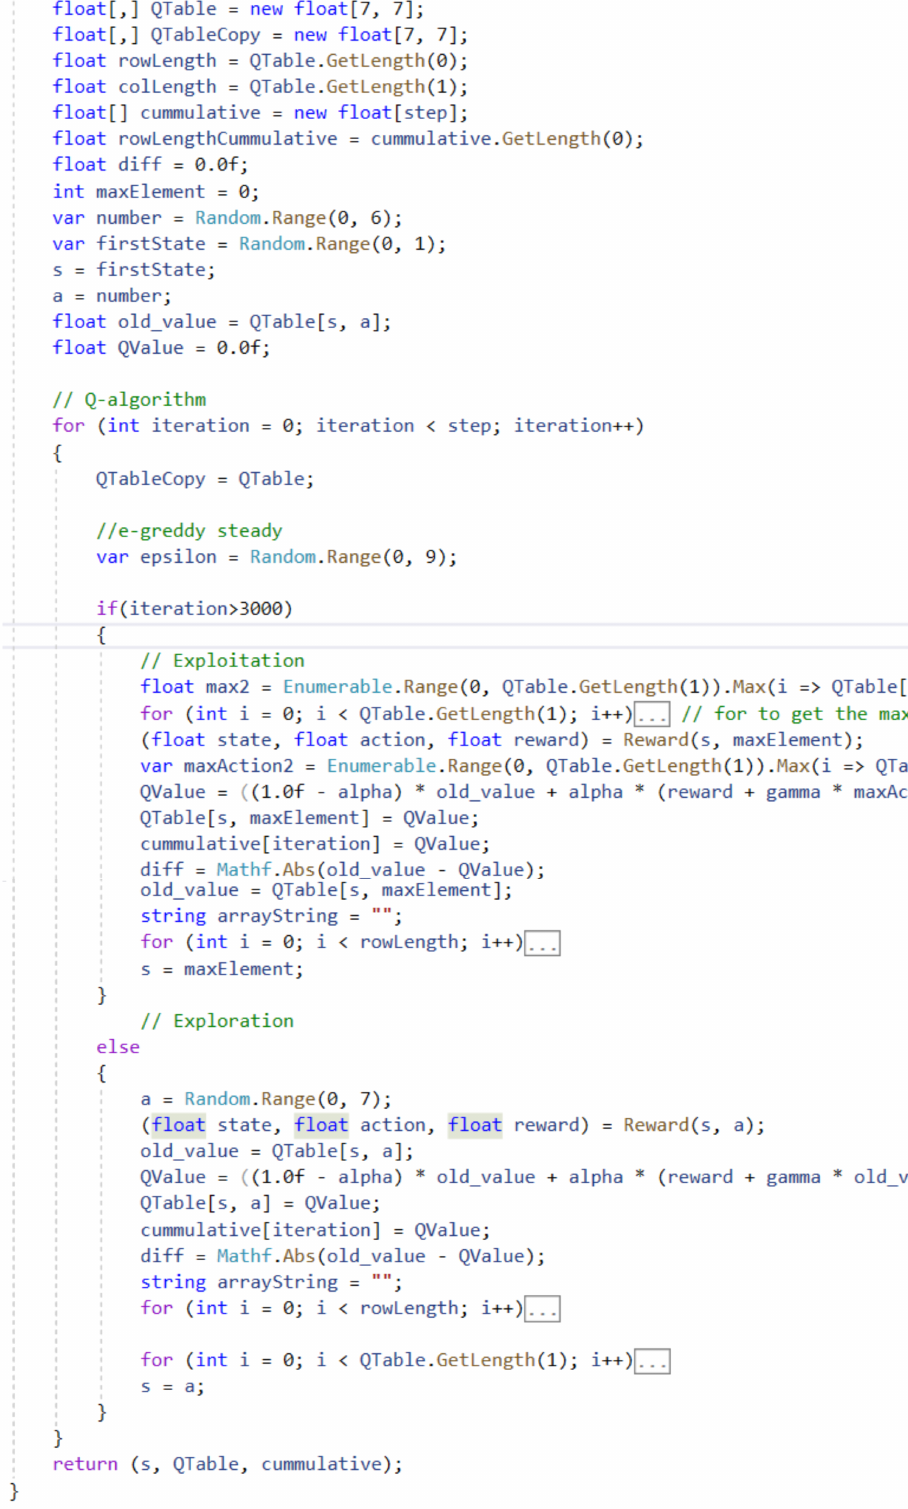
Figure A3. Fragment of the Q-learning algorithm implemented in the virtual